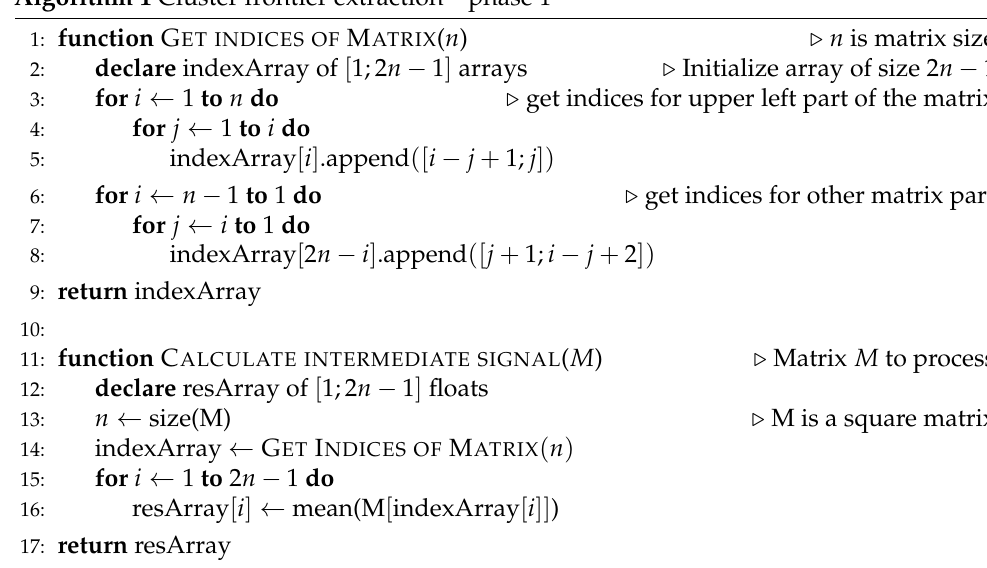
Algorithm 1 Cluster frontier extraction—phase